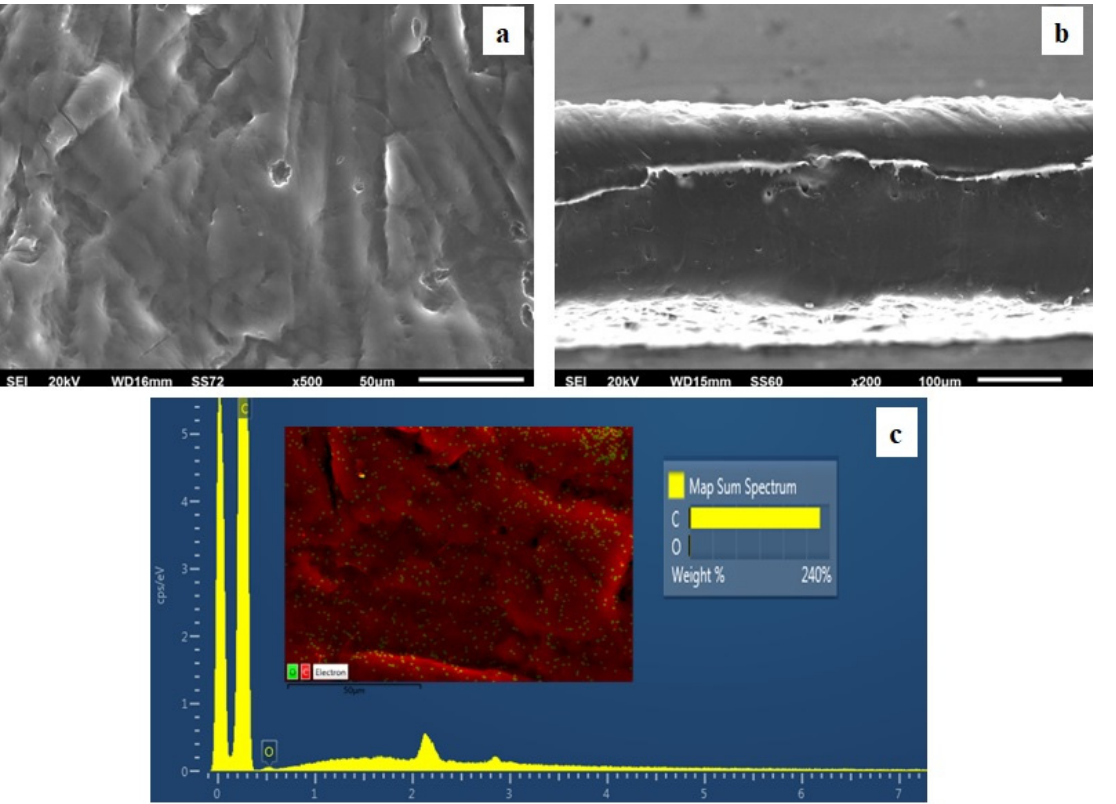
Figure 4. ( a ) SEM images of surface and ( b ) cross-section for the pure film of LDPE. ( c ) Energy dispersive spectrometer (EDS) spectra, relative elemental analysis, and mapping of the surface from the SEM image at x1000 magnification.